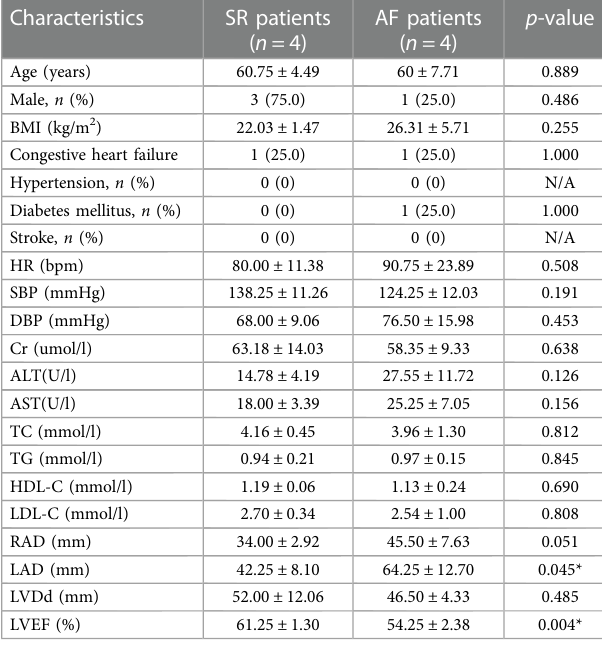
( Figure3A ).Atotalof34,022lncRNAsweredetected,box-whiskerplot